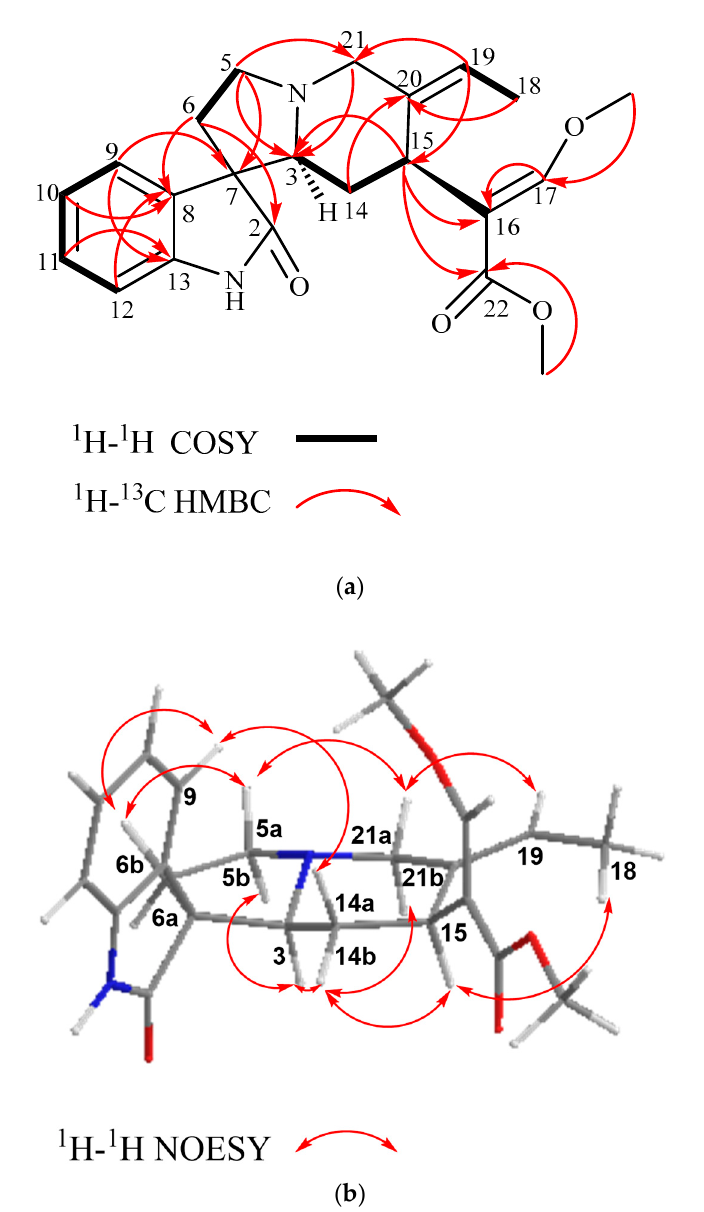
Figure 2. ( a ) Selected COSY and HMBC and ( b ) selected NOE correlations of compound ( 1 ) (most stable conformation, Chemdraw3D).